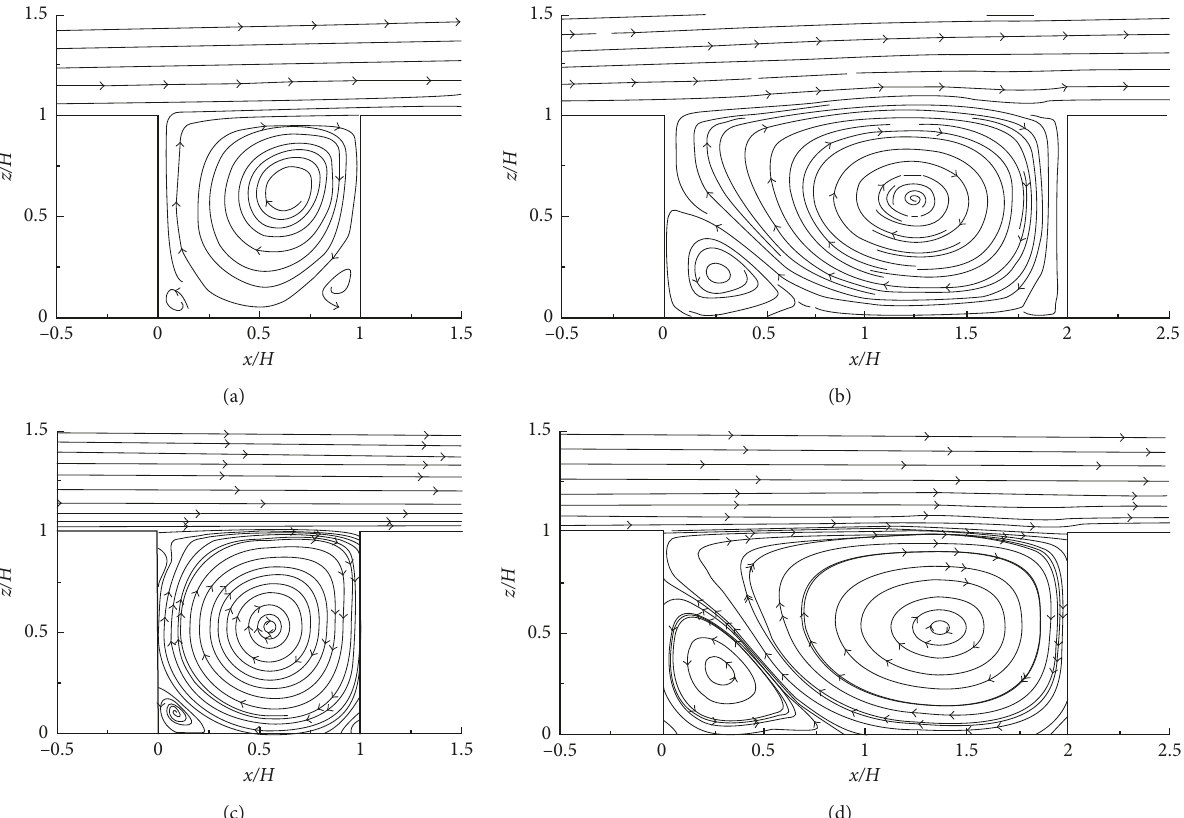
Figure 8: Streamlines of the mean velocity magnitude for AR measured in the laboratory (b) and simulated